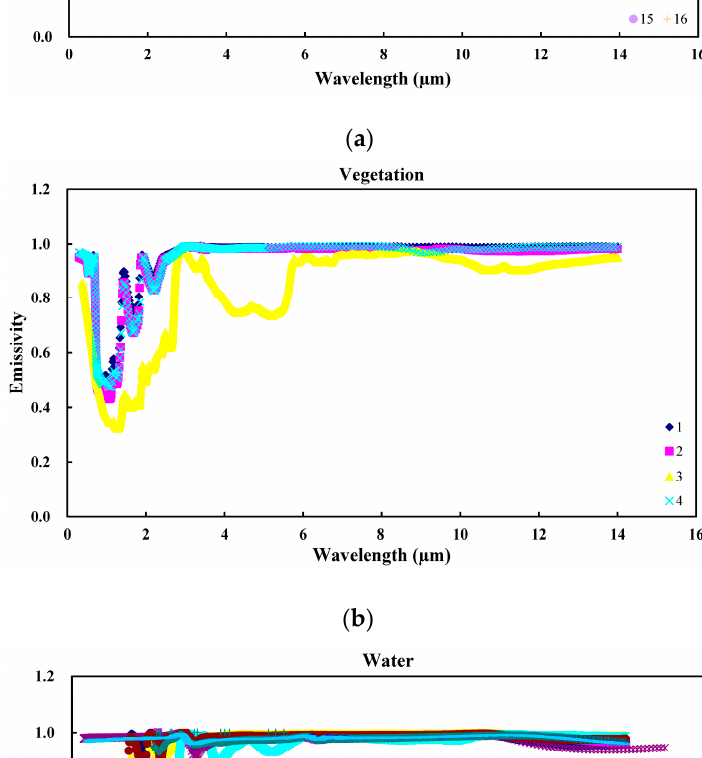
Table 3. Sensor characteristics commonly used for retrieving LST.